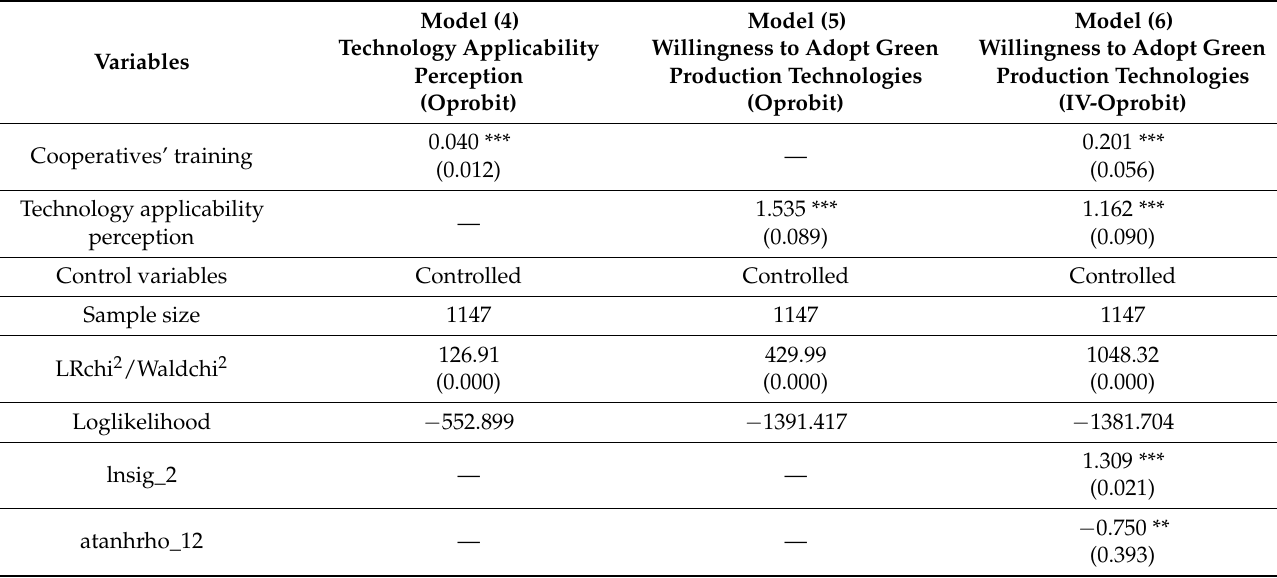
Table 5. Mediation effect of technology applicability perception.